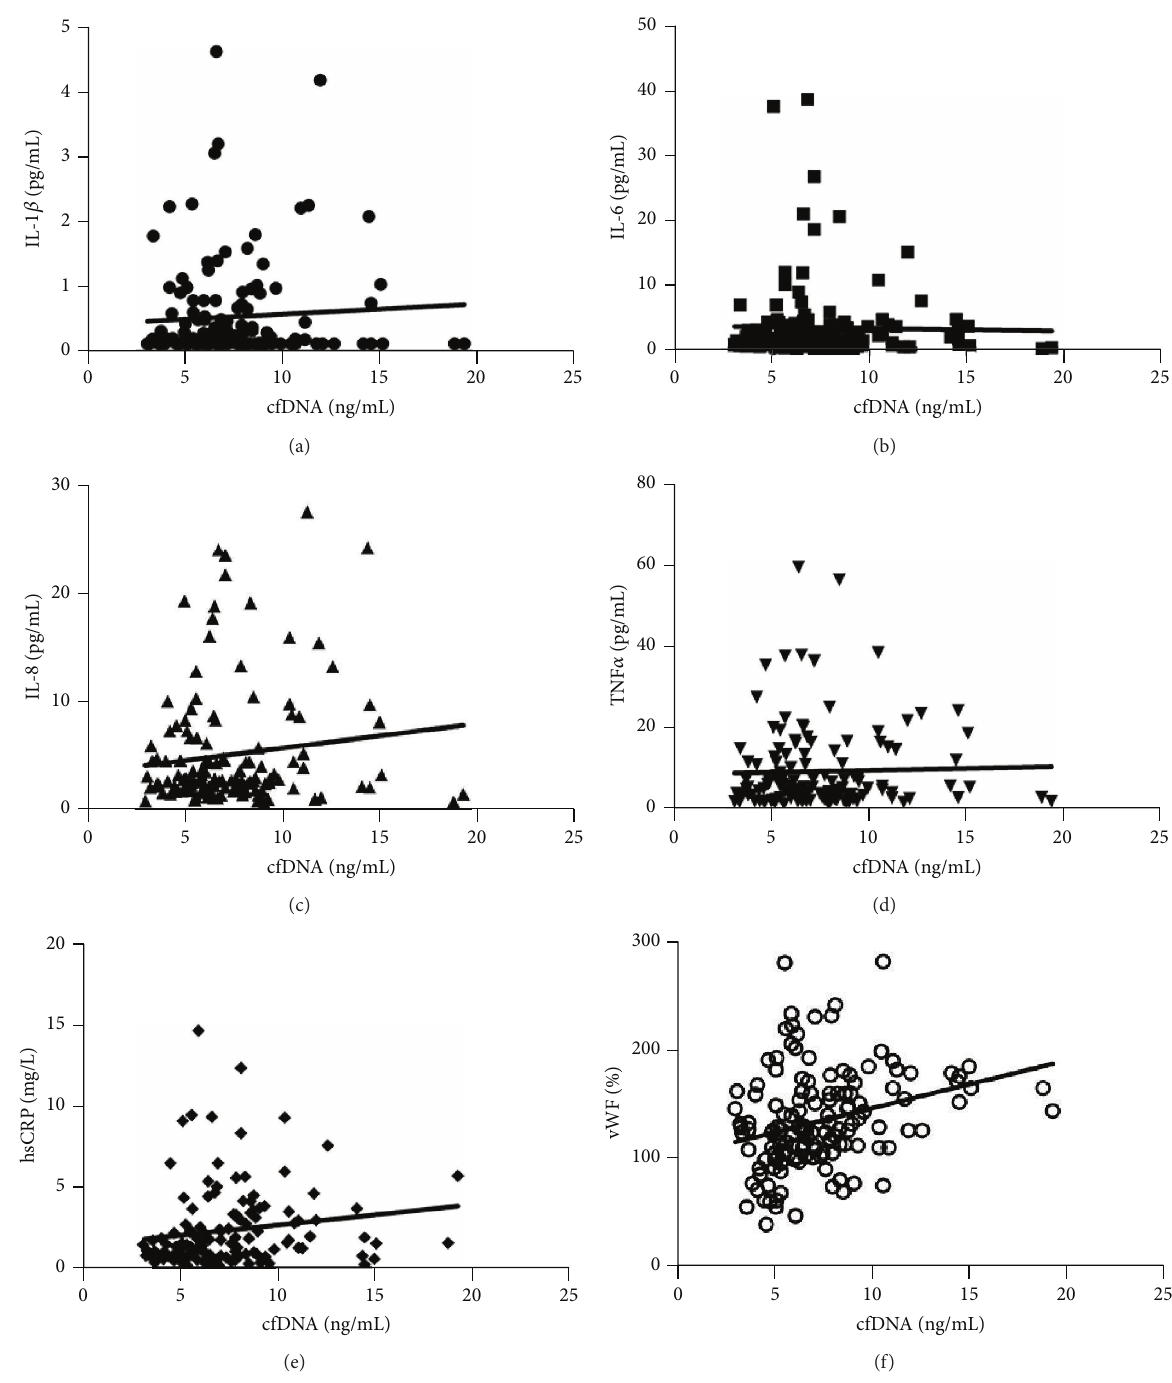
Figure 4: Correlation between cfDNA and cytokine levels. (a) IL-1 𝛽 , 𝑃 = 0.48 ; (b) IL-6, 𝑃 = 0.81 ; (c) IL-8, 𝑃 = 0.15 ; (d) TNF 𝛼 , 𝑃 = 0.75 ; (e) hsCRP, 𝑃 = 0.0497 ; and (f) vWF, 𝑃 = 0.0005 .